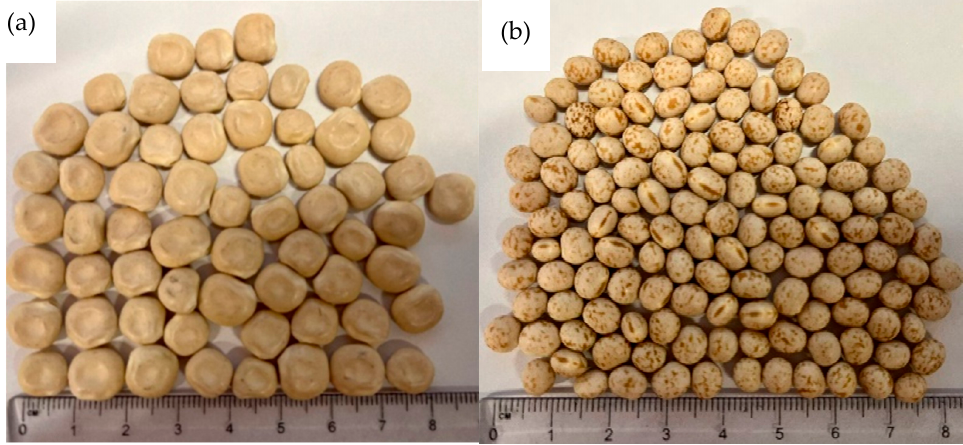
Figure 1. External appearance of Lupins: ( a ) L. albus , ( b ) L. angustifolius .